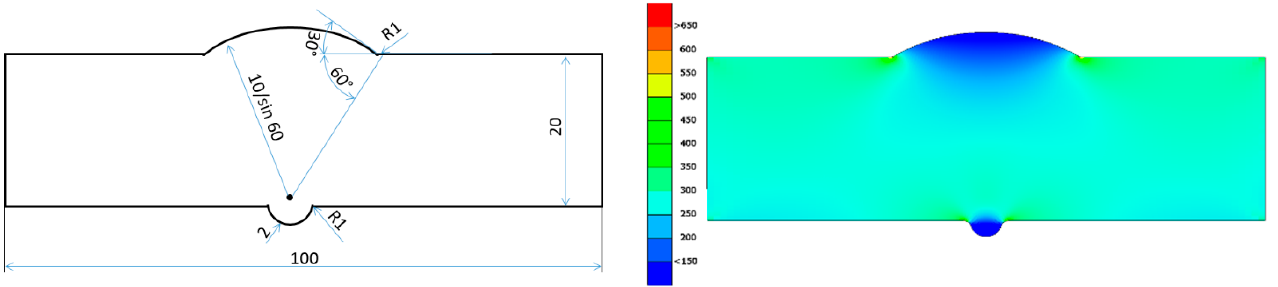
Figure 8. V-weld geometry (dimensions are in millimeters) and stress distribution around the weld obtained by FEM simulation (stresses are in MPa). obtained by FEM simulation (stresses are in